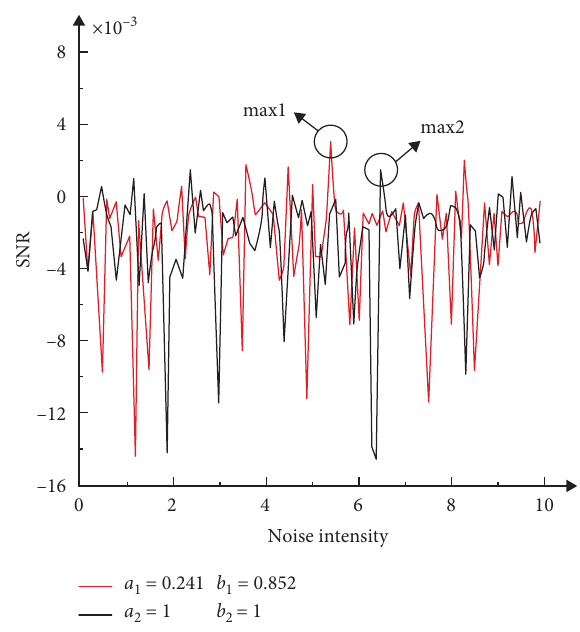
Figure 4: SNR variation of analog signal X